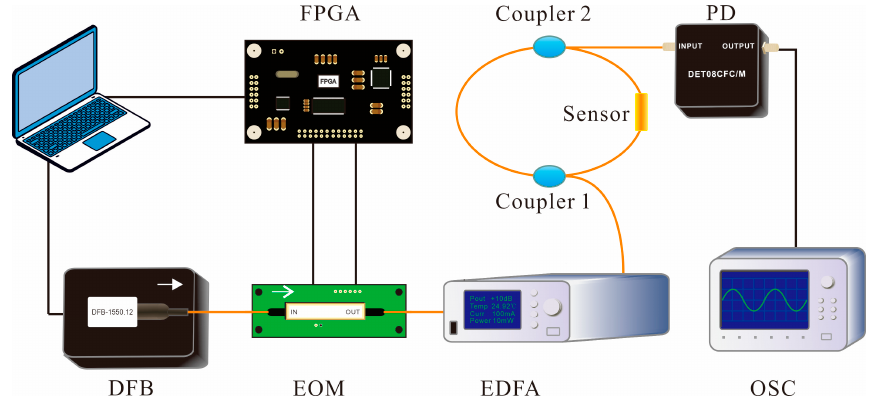
Figure 5. Schematic diagram of the static ice pressure detection system.